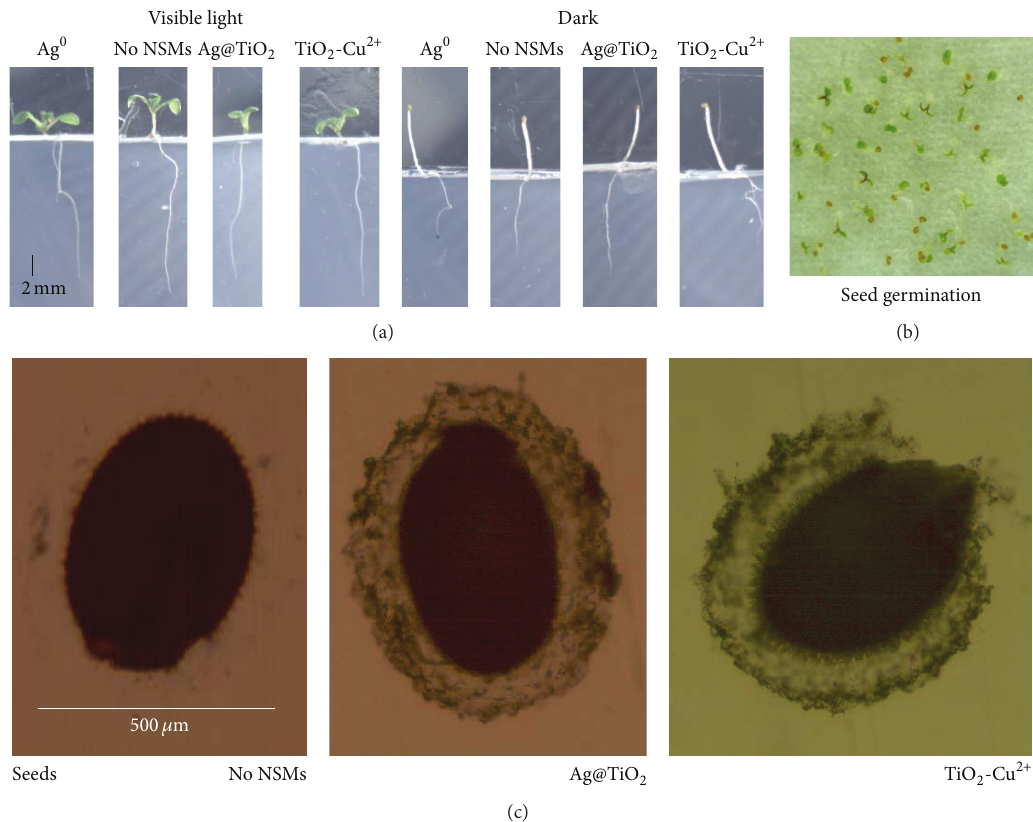
Figure 4: Seeds of A. thaliana exposed to Ag@TiO 2 and TiO 2 -Cu 2+ . (a) Seedlings grown in MS agar medium, 𝑛 = 10 ; (b) germinated seeds, 𝑛 = 90 ; (c) NSMs adhered on